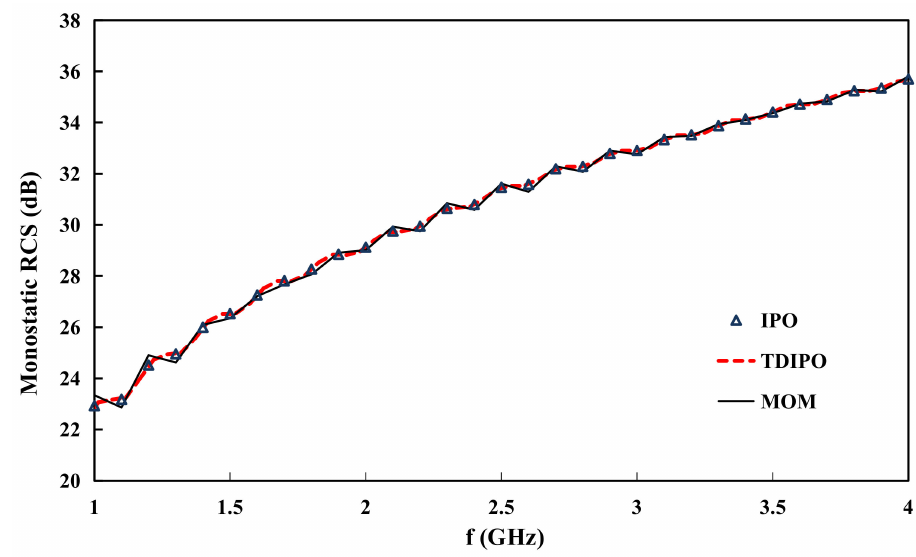
Figure 14. Monostatic RCS results for the dihedral angle model with different methods.